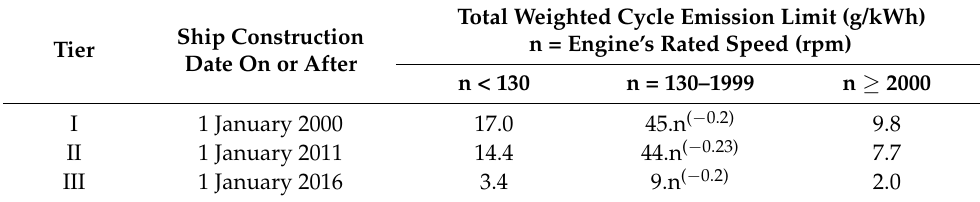
Table 1. Levels norm for NO x emissions from ships